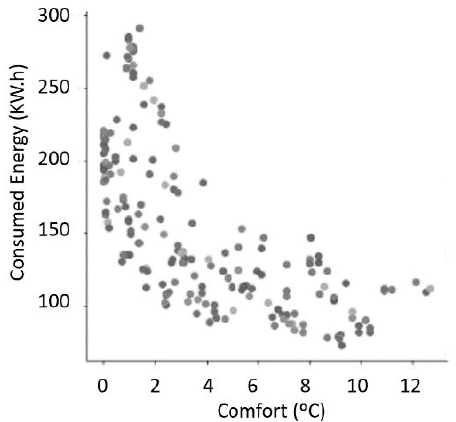
Figure 8. 2D objective space of Consumed Energy [kW.h] vs. Comfort [°C].